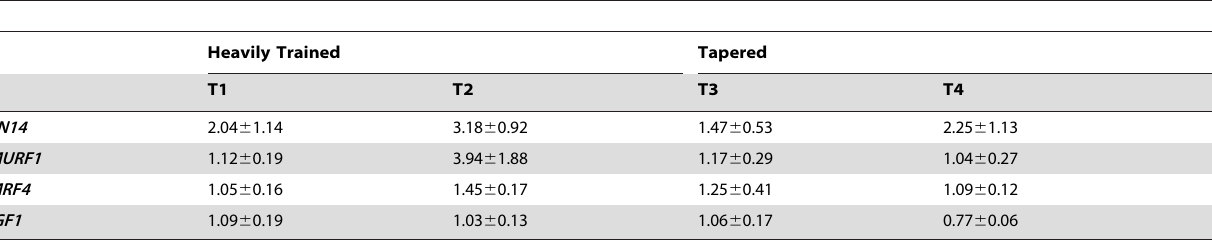
Table 3. Genes not responsive to exercise in MHC I fibers in the heavily trained or tapered state.